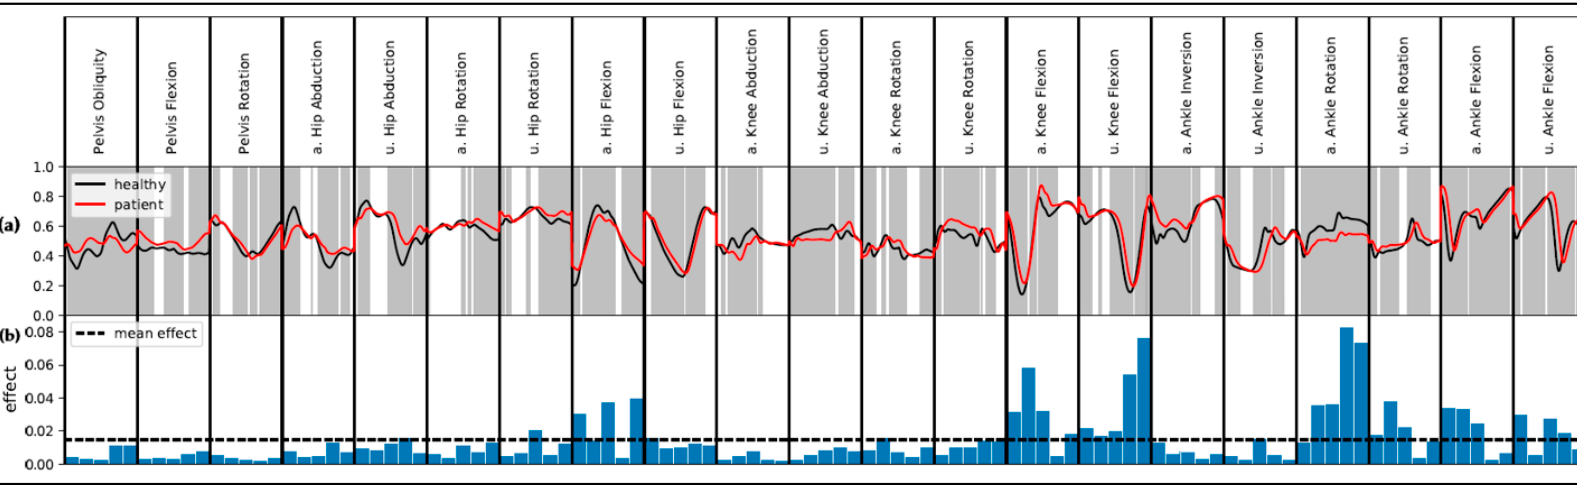
Figure 2. Global results for the use of the waveform data (V_waves). For visualization reasons, data are separately scaled to a range from 0 to 1 for each variable. ( a ) Mean movements for healthy subjects and patients after total hip arthroplasty (THA). The grey areas indicate statistical difference (alpha = 0.05) according to Statistical Parameter Mapping. ( b ) Aggregated Local Interpretable Model-Agnostic Explanations (LIME) results as mean absolute effect. Abbreviations: a. = affected side; u. = unaffected side.